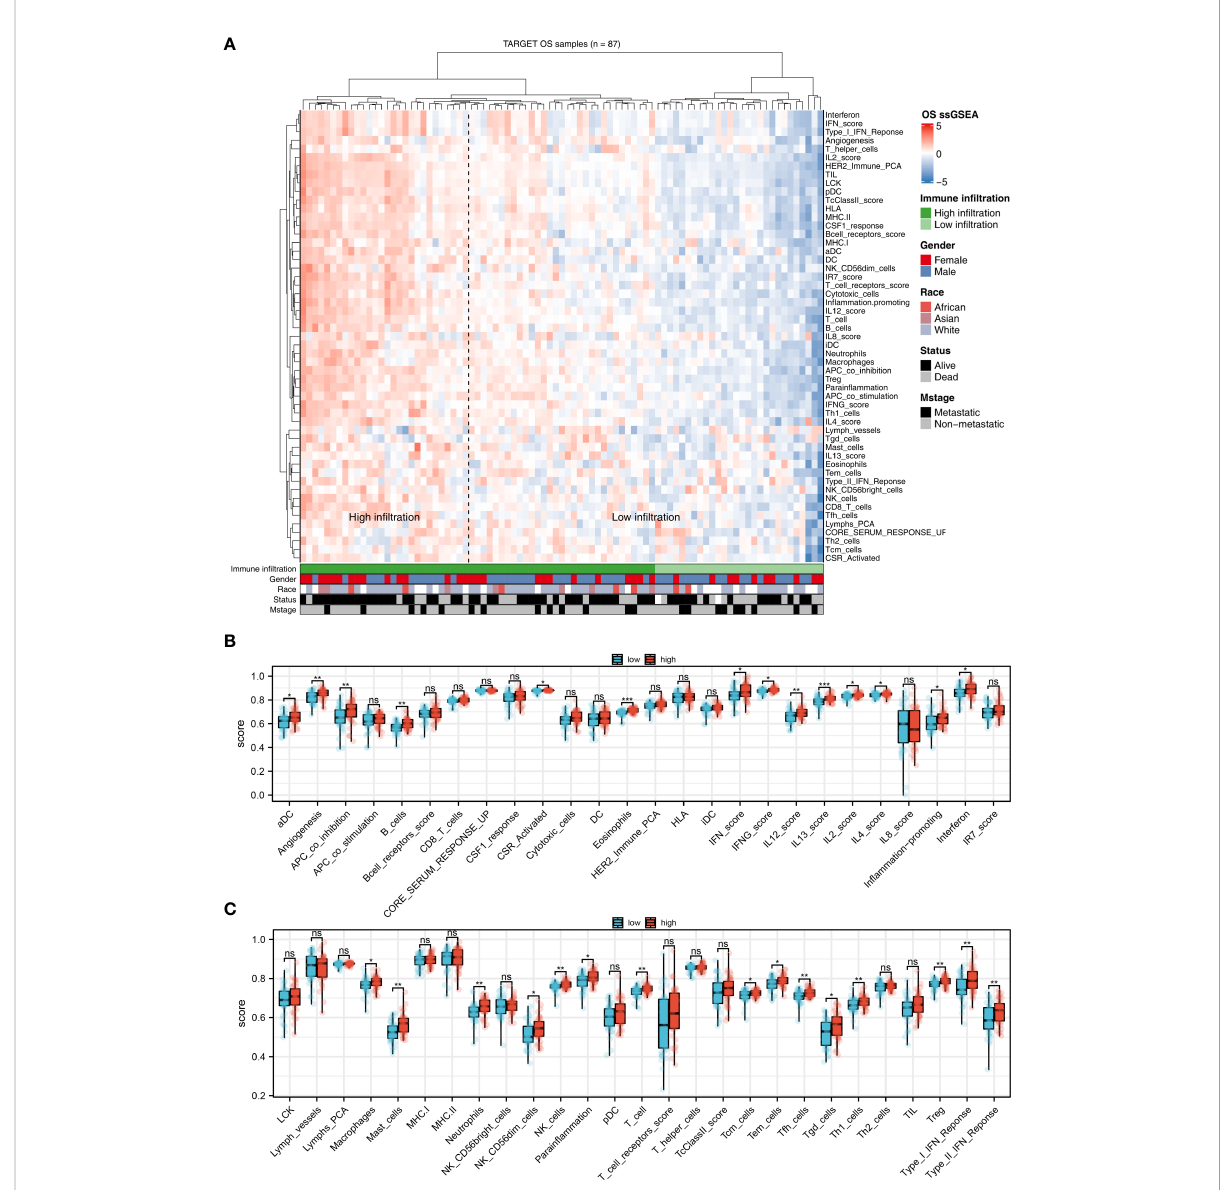
FIGURE 4 The correlation between sphingolipid metabolism and immune terms (A) : ssGSEA algorithm was performed to quantify the 53 immune terms; (B, C) : Immune terms difference between patients with high and low sphingolipid metabolism activity. ns, P < 0.05. *P < 0.05; **P < 0.01; ***P <